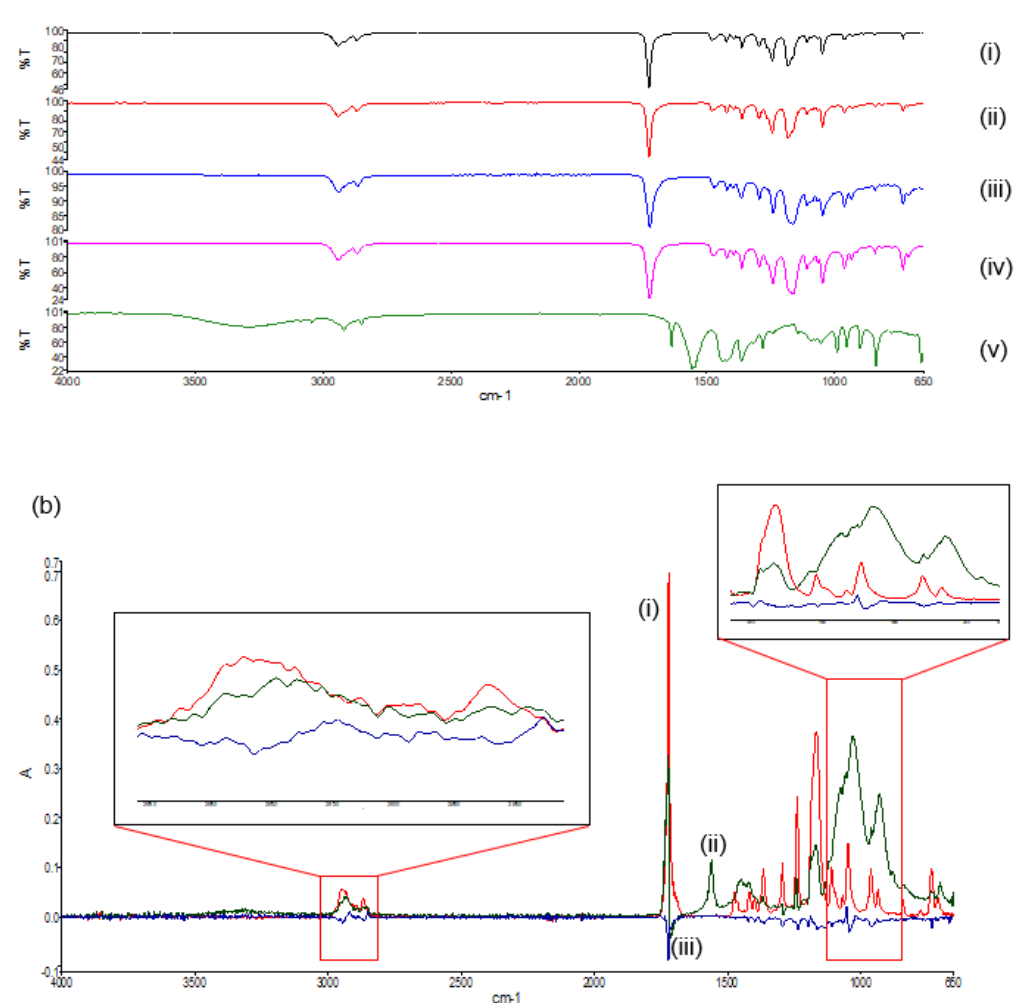
Figure 7. FTIR spectra of ( a ) the transmittance profile of (i) PCL 10 ,(ii) PCL 80 , (iii) the PCL blend, (iv) the 3D printed PCL blend, and (v) the PVA–PAA hydrogel; and ( b ) the deconvolution absorbance profile of (i) PCL 10 , (ii) PCL 80 , and (iii) the PCL blend.